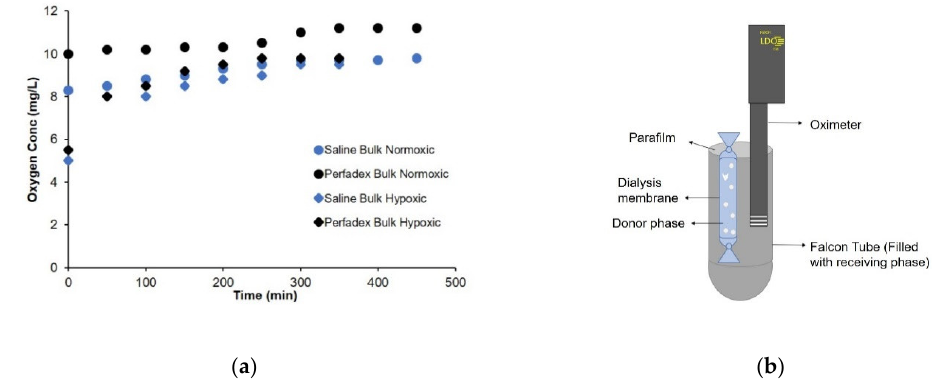
Figure 3. Examples of passive oxygen release in fluids: ( a ) oxygen concentration in different liquids, saline and Perfadex, in normoxic and hypoxic bulk at 4 °C; ( b ) illustration of the device for measuring oxygen diffusion from the donor compartment to the bathing medium. Data were measured with accuracy of ±1.5% of the nominal value.